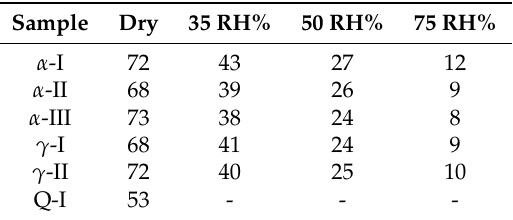
Figure 11. DMTA results, tan( δ ) as a function of temperature for samples conditioned at different humidity; markers are the T g at ( ◻ ) RH 0 %, ( ◯ ) RH 35%, ( ◁ ) RH 50%, ( ◇ ) RH 75%. ( a ) samples α -I and γ -I; ( b ) α -II, α -III and γ -II. Table 4. Glass transition temperature